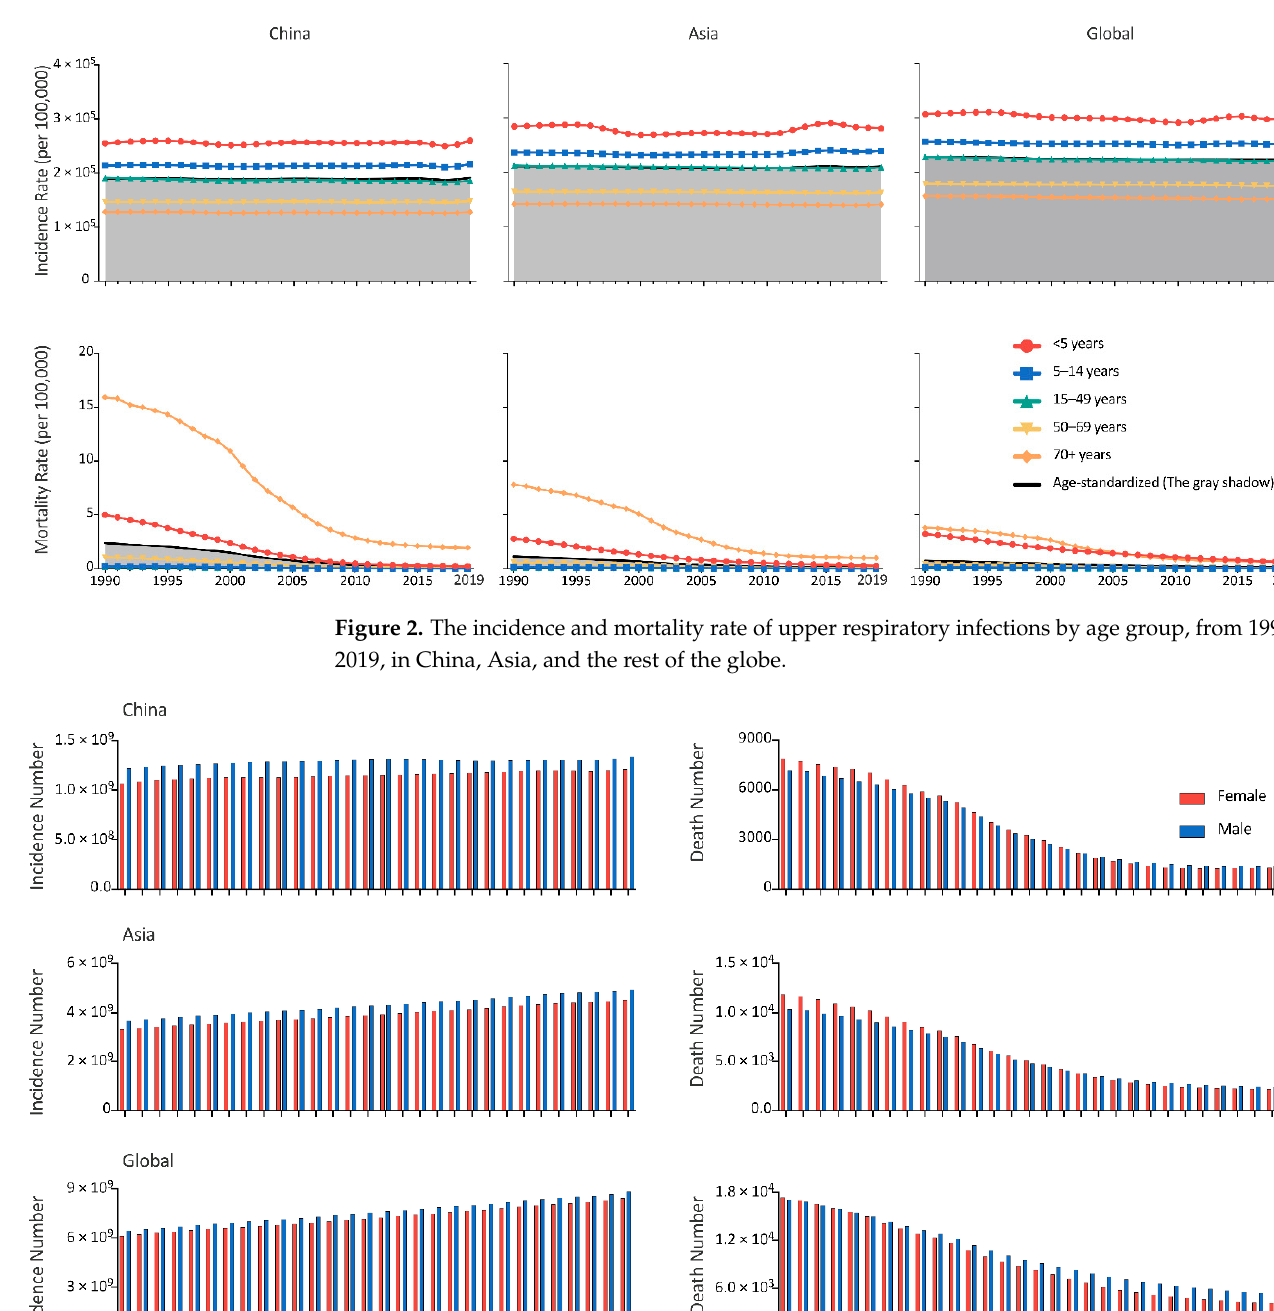
Figure 4. EAPCs of age-specified incidence and mortality rates of upper respiratory infections from 1990 to 2019, in China, Asia, and the rest of the globe. EAPC, estimated annual percentage change.